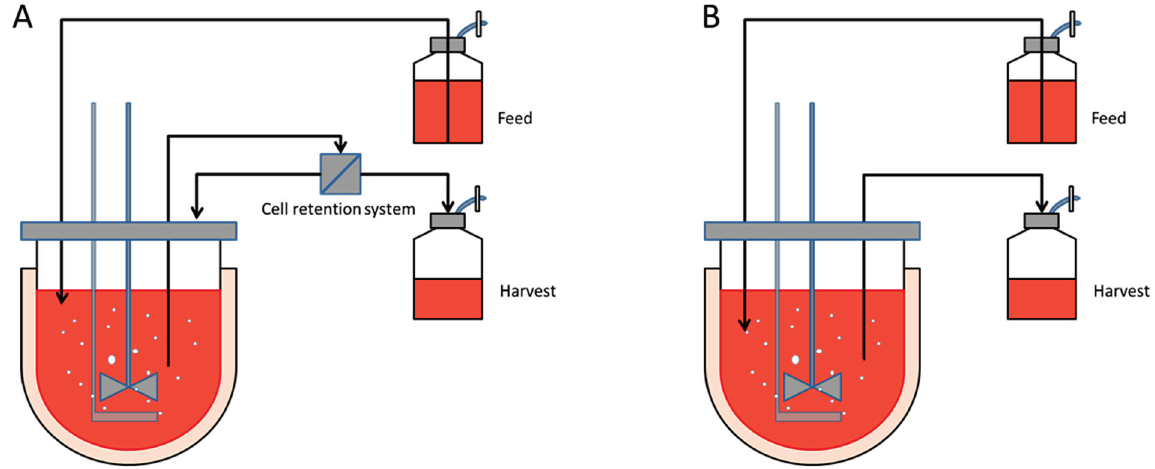
Figure 1. Diagram of a perfusion culture setup. ( A ) Schematic representation of a perfusion culture for suspension cells in a stirred tank reactor. A cell retention system, such as a microfilter, is necessary to separate the cells from spent media; ( B ) Schematic representation of a perfusion culture for immobilized cells. The microcarriers or microcapsules, typically with a 240 µm radius, are sufficiently large to be retained within the vessel by a wire